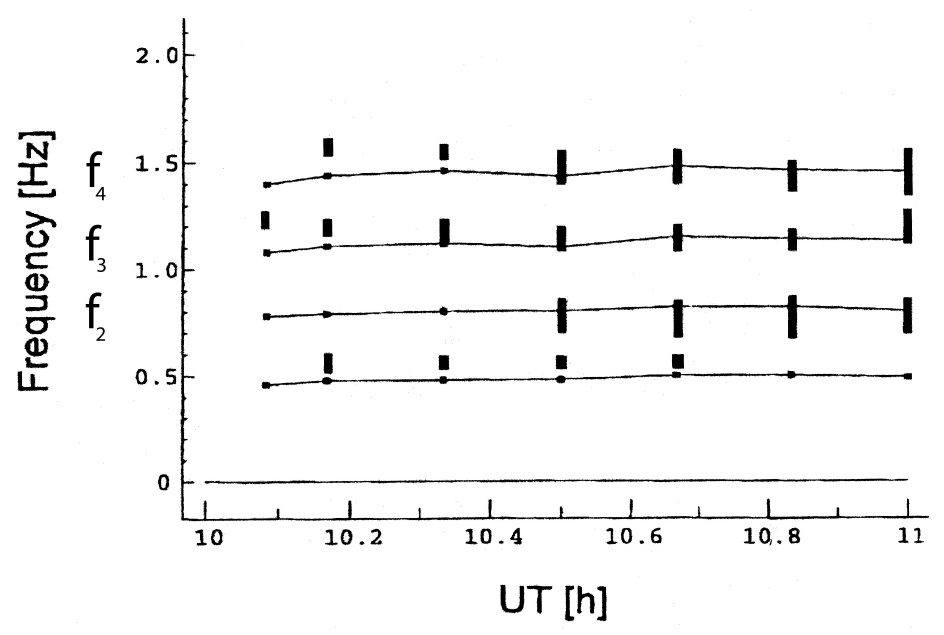
Fig. 4. Calculated harmonic frequencies of the resonator (horizontal lines) and the observed frequencies of the Pc1 bands (vertical lines) at KIL station on 2 December at 10:00–1100 UT. The calculations were carried out on the basis of the EISCAT data sampling intervals with 1T = 5min. The input parameters (incident L || mode wave and z max = 2000km) are the same as in Fig.